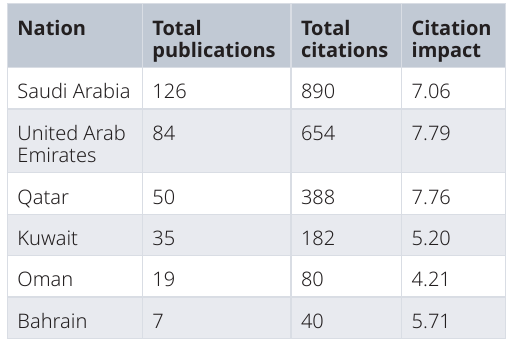
Table 2. Road traffic injuries research productivity in terms of publications, citations, and impact for each nation in the Gulf Cooperation Council region